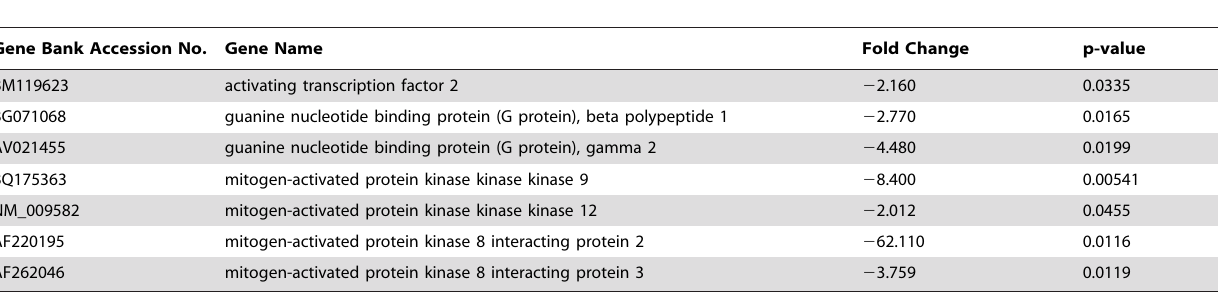
Table 5. Downregulation of stress activated protein kinase (SAPK) pathway genes in mouse skeletal muscle at 4 days 2-AA treatment versus control